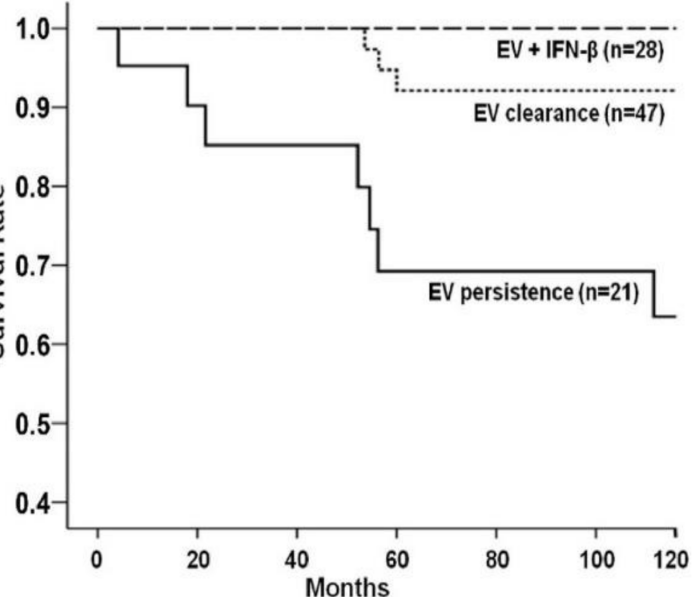
Figure 4. Mortality rate among patients positive for enterovirus (EV) infection: unadjusted survival according to virus analysis at follow-up. Spontaneous or interferon (IFN)- β -drug-induced enterovirus clearance was associated with a significantly reduced mortality rate in comparison to patients who had enterovirus persistence ( p = 0.0005 by the log-rank test)